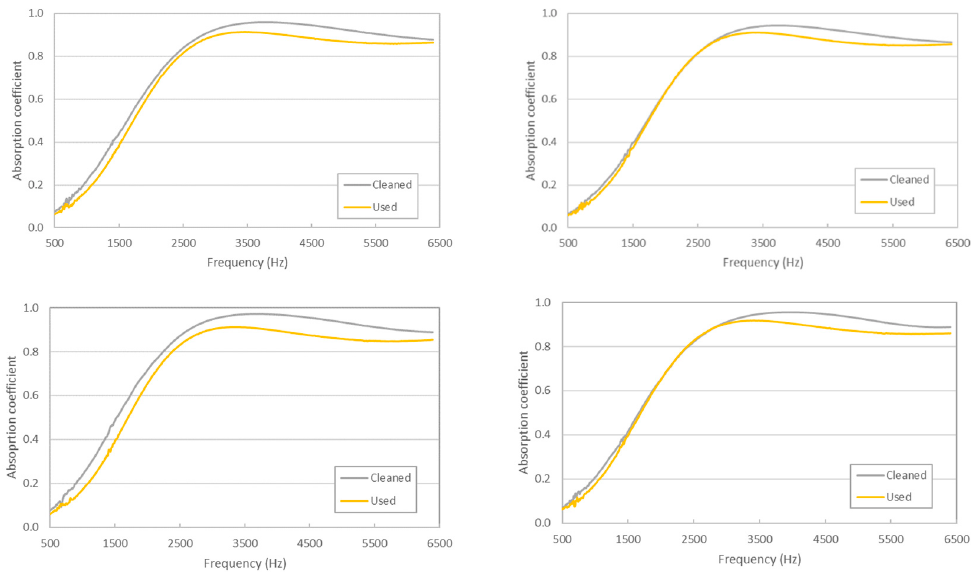
Figure 9. Effect of chemical cleaning in the absorption coefficient values.